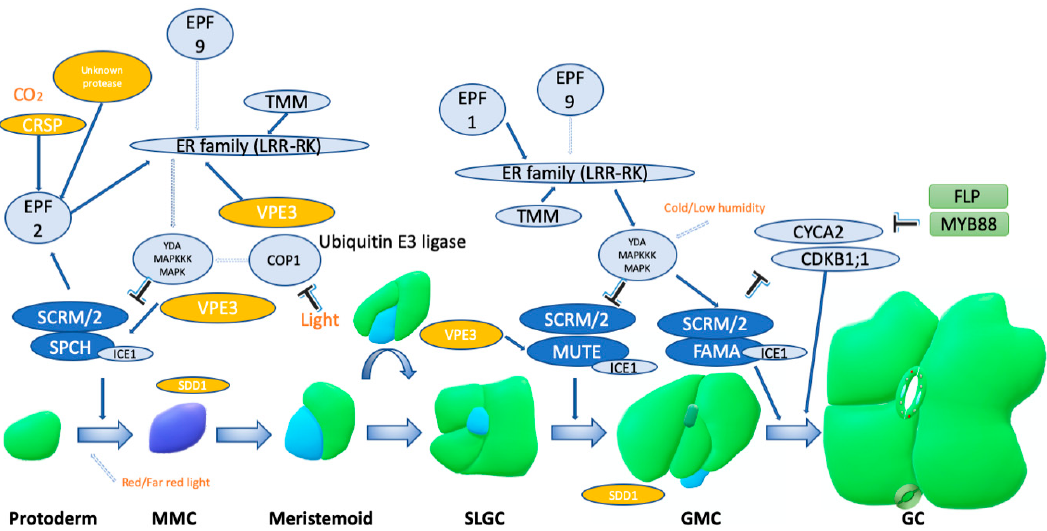
Figure 1. The main stomatal developmental pathway. The experimentally confirmed steps are shown as solid lines, and the steps that are yet unverified are shown as non-colored dotted lines. An arrow indicates a positive regulation, while a ‘T’ indicates negative regulation. Dark blue bubbles indicate critical controllers of the stomatal development, light blue bubbles indicate secondary regulators of the pathway, yellow bubbles mark the proteases that are involved in the pathway. Additional abbreviations: SCRM: Scream, YDA: YODA, MAPK: MAP Kinase, MAPKKK: MAPKK Kinase, SLGC: Stomatal lineage ground cell, FLP: Four Lips [16,17].